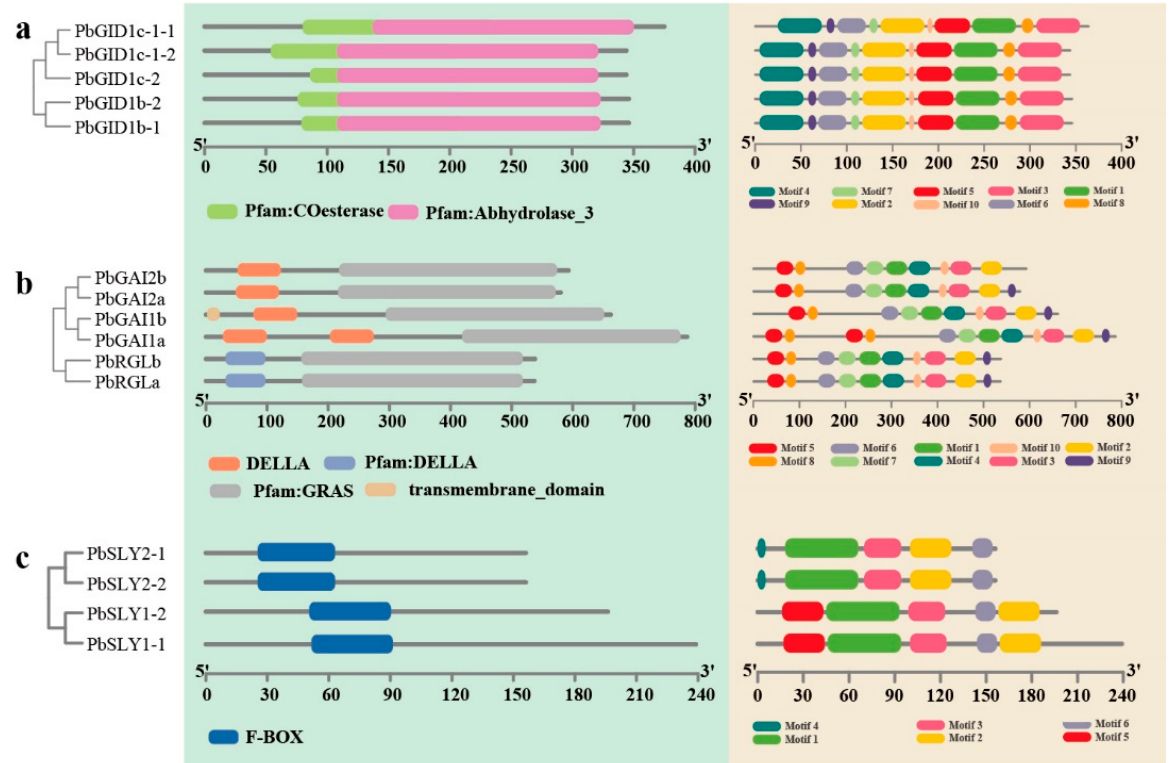
Figure 3. Identification of the conserved domains and motifs of PbGID1s, PbDELLAs, and PbSLYs in ‘duli’ pear ( Pyrus betulifolia Bunge). ( a ) The conserved domains and motifs of PbGID1s. ( b ) The conserved domains and motifs of PbDELLAs. ( c ) The conserved domains and motifs of PbSLYs. Individual domains (in green background on the left) and motifs (in peach background on the right) are indicated in different colored horizontal bars below each figure. Numbers on the X -axis indicate amino-acid positions of the proteins.